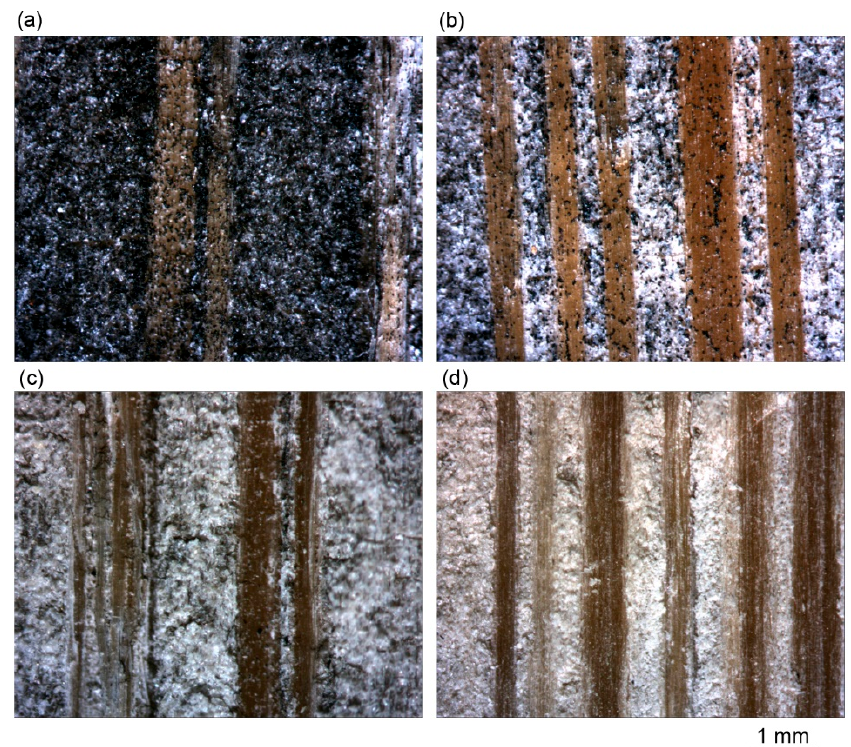
Figure 6. Optical microscope pictures after the two-month test period for ( a ) pristine bamboo; ( b ) ZnO-B; ( c ) TiO 2 -B; and ( d ) ZnO/TiO 2 -B, respectively.